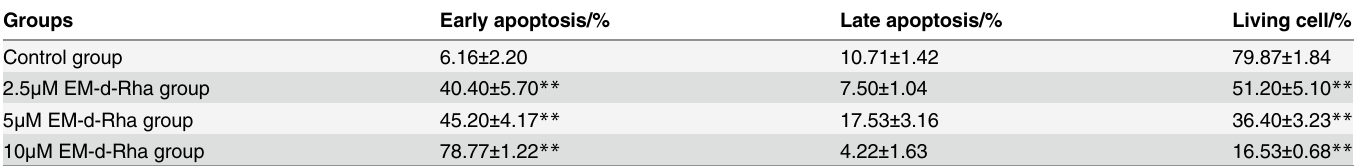
Table 4. The apoptosis rates of HepG2 treated with different concentration EM-d-Rha. Groups